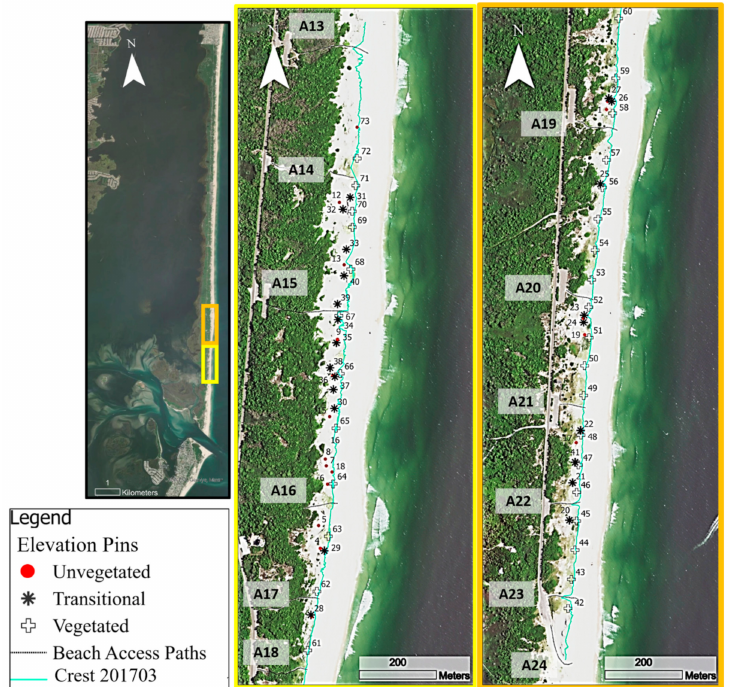
Figure 1. Island Beach State Park, NJ collection area. Data collection consisted of quantifying